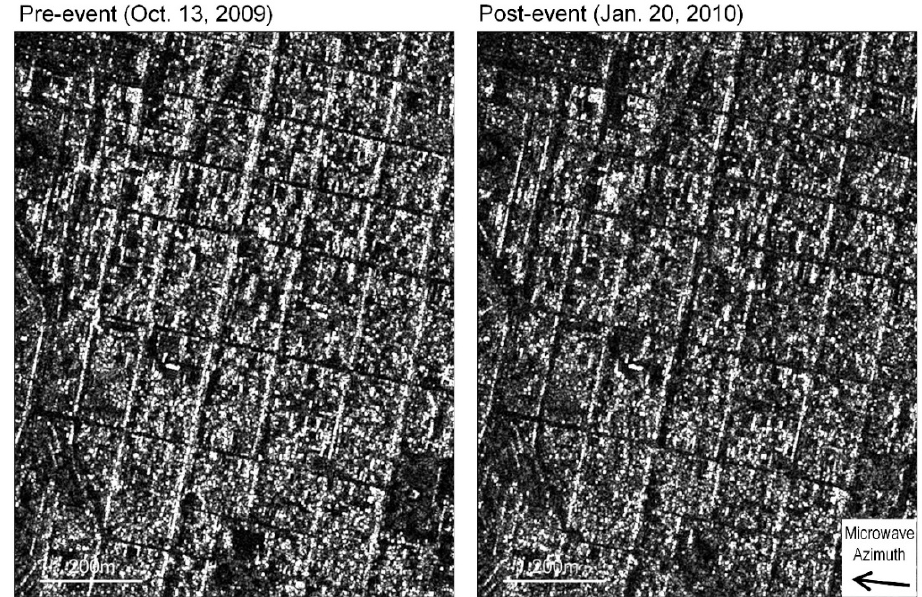
Figure 8. Pre- and post-event TerraSAR-X (TSX) images in target area observed in descending orbit. Source: [10]. Figure 3, page 595.